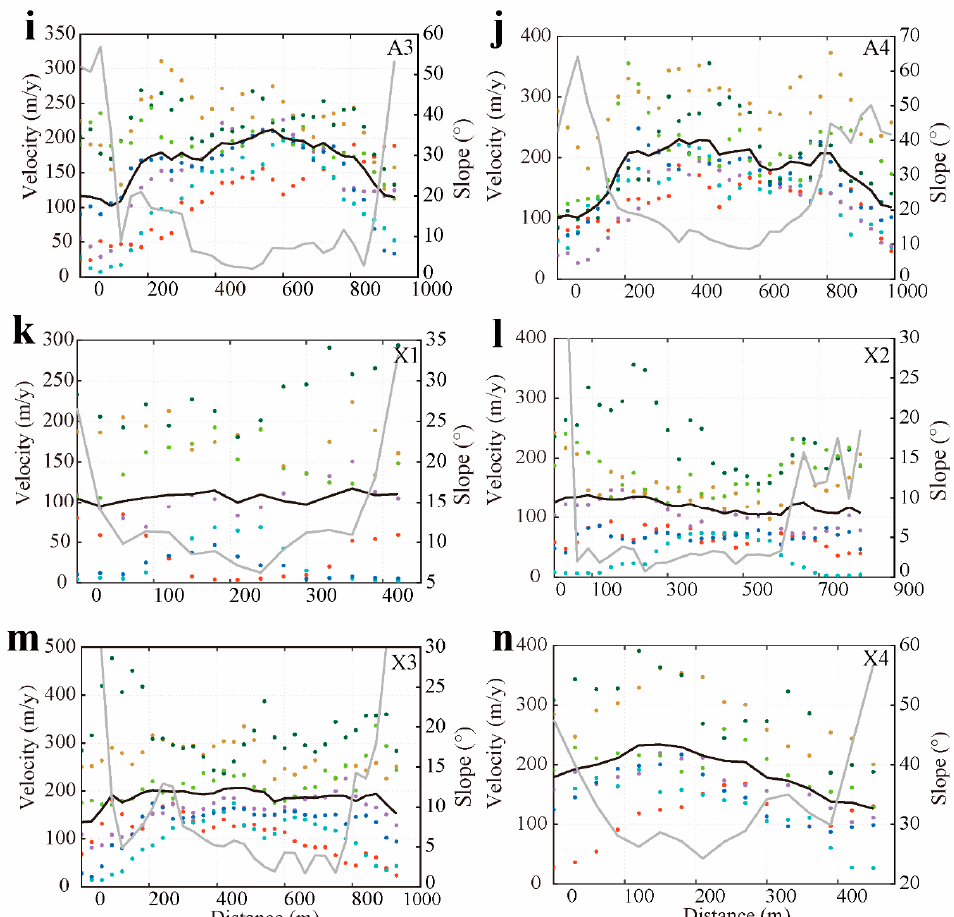
Figure 9. Transects of surface velocity 2013–2020. Yanong Glacier at: ( a ) Y1, ( b ) Y2, ( c ) Y3, and ( d ) Y4; Parlung No 4. Glacier at: ( e ) P1 and ( f ) P2; Azha Glacier at: ( g ) A1, ( h ) A2, ( i ) A3, and ( j ) A4; Xueyougu Glacier at: ( k ) X1, ( l ) X2, ( m ) X3, and ( n ) X4; location of transects shown in Figure 4; Date format is yyyymmdd-yyyymmdd; solid black line is the mean velocity profile.